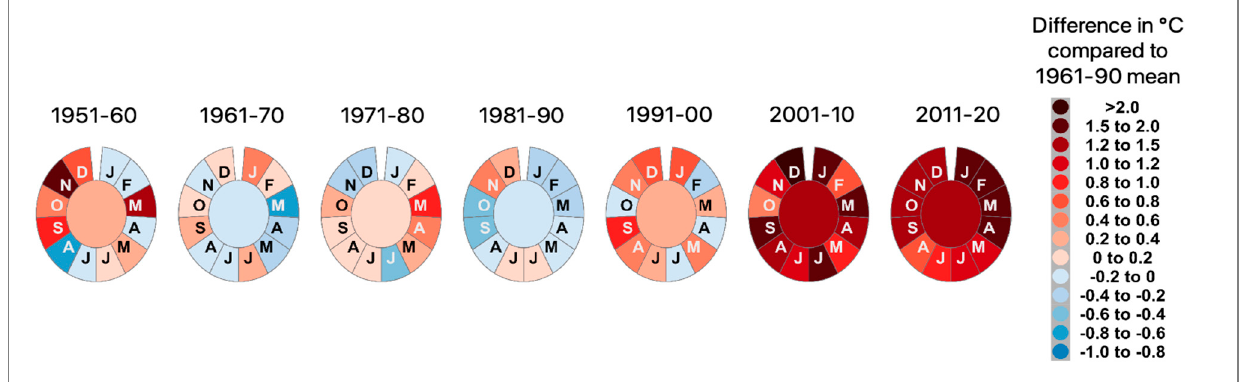
Figure 6. Temperature anomalies for each month per decade, 1951–2020, Westfjords average (average created from six stations, i.e., Gjögur (1949–2020), Hornbjargsviti (1949–2020), Æðey (1954–2020), Bolungarv í k (1949–2020), Reykh ó lar (1961–2020) and Lambavatn